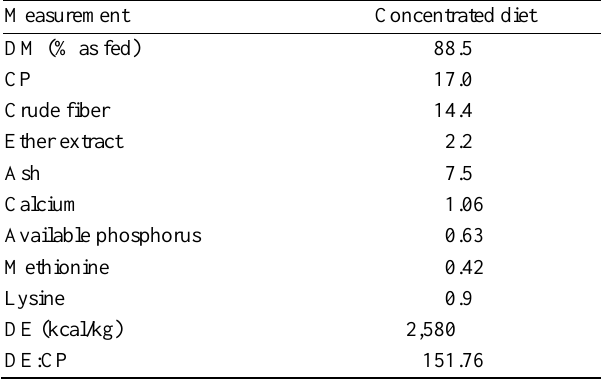
Table 1. Chemical composition of the concentrated